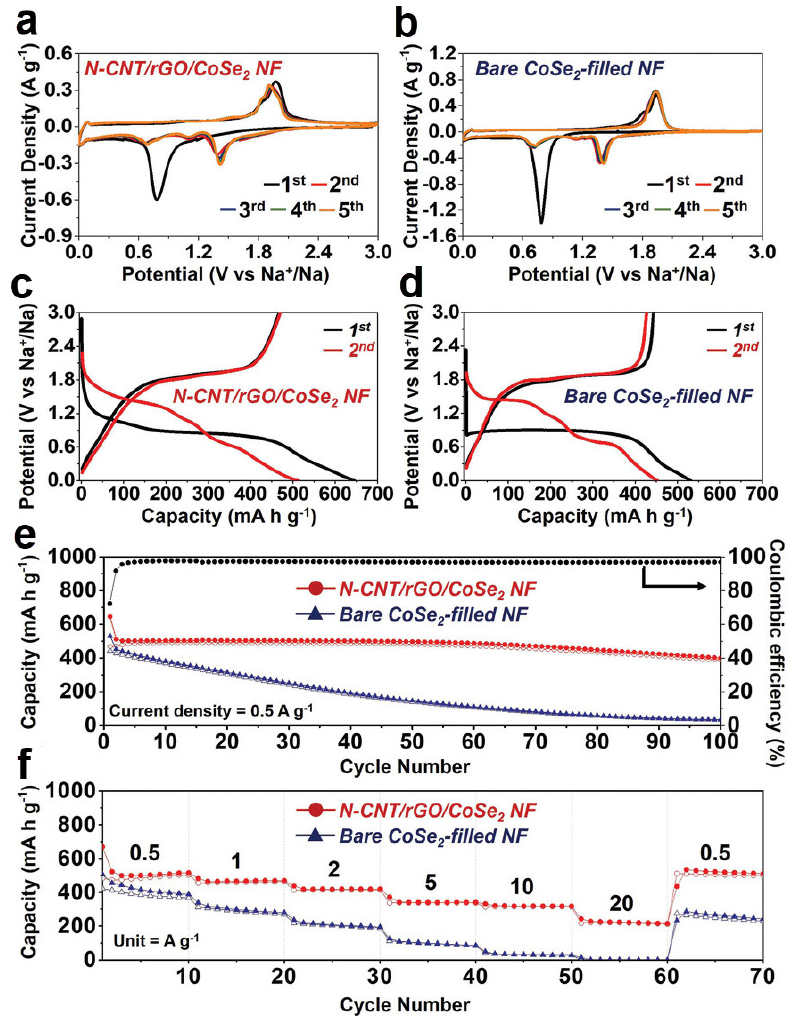
Figure 15. Electrochemical characteristics of N-CNT/rGO/CoSe 2 NF and bare CoSe 2 -filled NF for SIBs assembled using carbonate-based electrolytes: ( a , b ) CV curves, ( c , d ) GCD curves at 0.5 A g − 1 , ( e ) Cycle ability at 0.5 A g − 1 , and ( f ) Rate properties. Reproduced with permission [90]. Copyright 2019, Wiley-VCH.